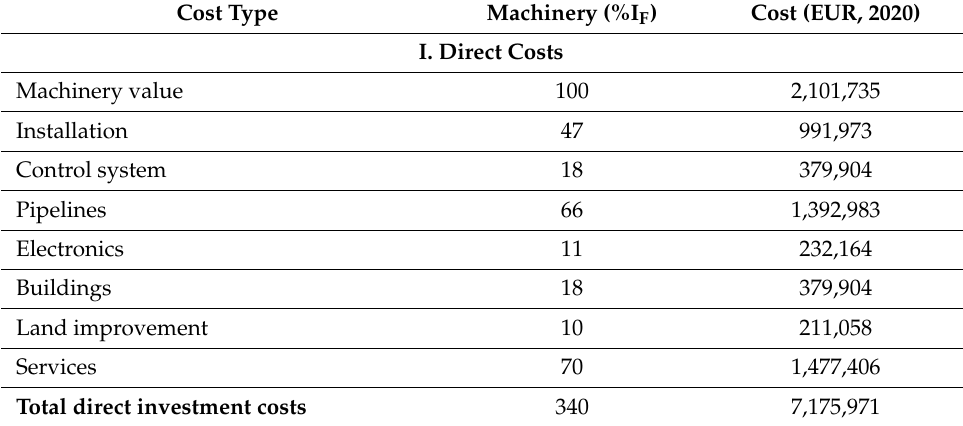
Table 10. Fixed investment (I F ) analysis based on Aspen Process Economic